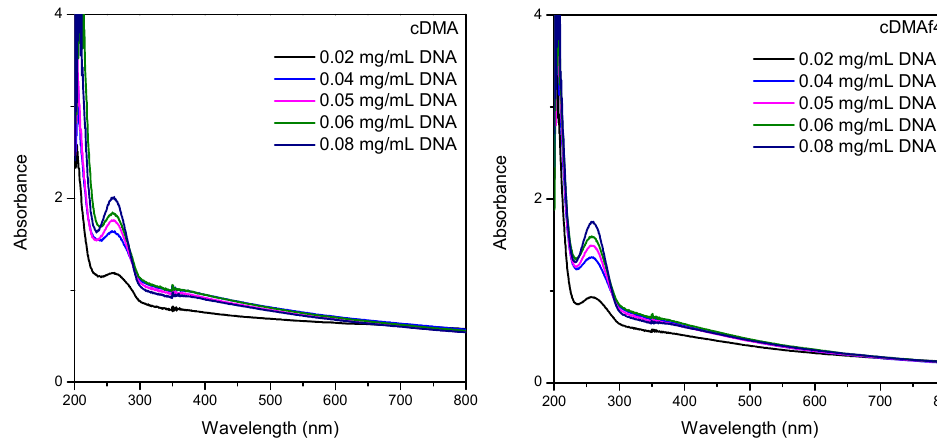
Figure 7. UV–vis spectra of DNA-interactions for cDMA ( left ) and cDMAf4 ( right ).